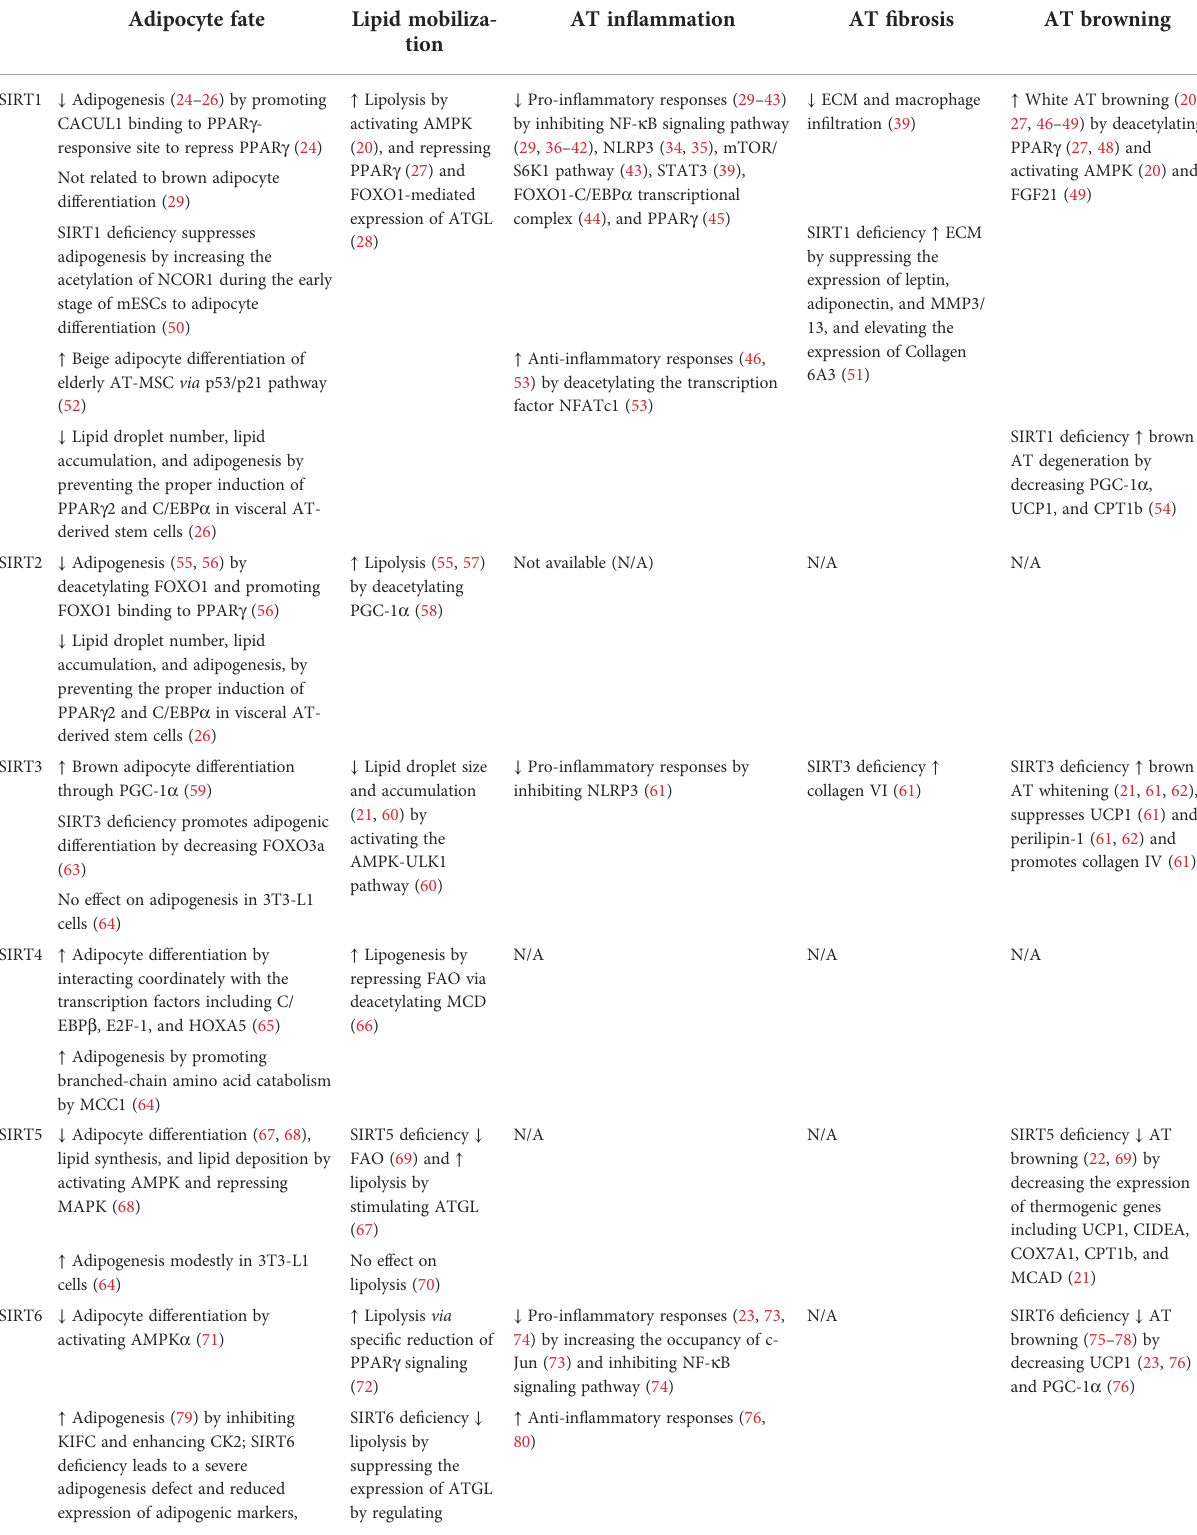
TABLE 1 Overview of the role of Sirtuins in adipose tissue